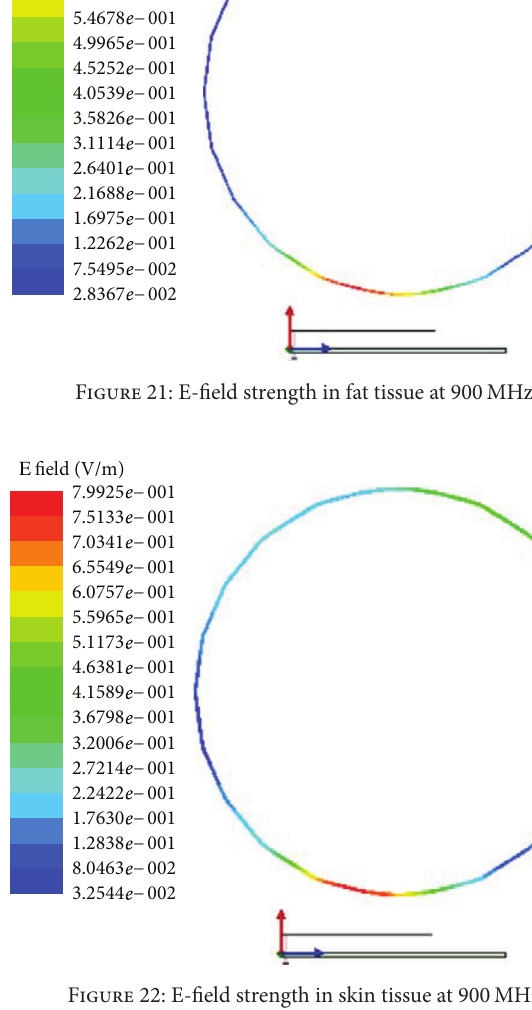
F 20: �-�eld strength in bone tissue at 900MHz.